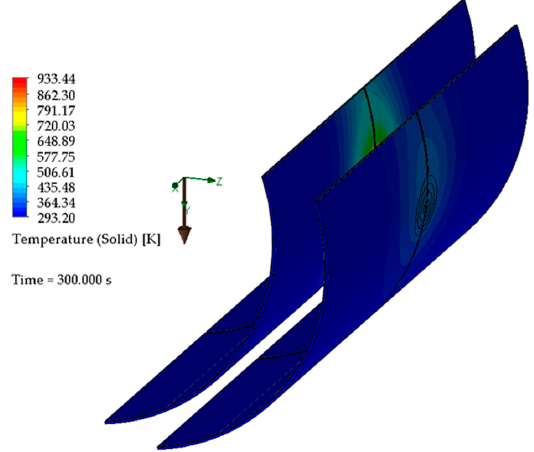
Figure 16. Temperature at 300 s.